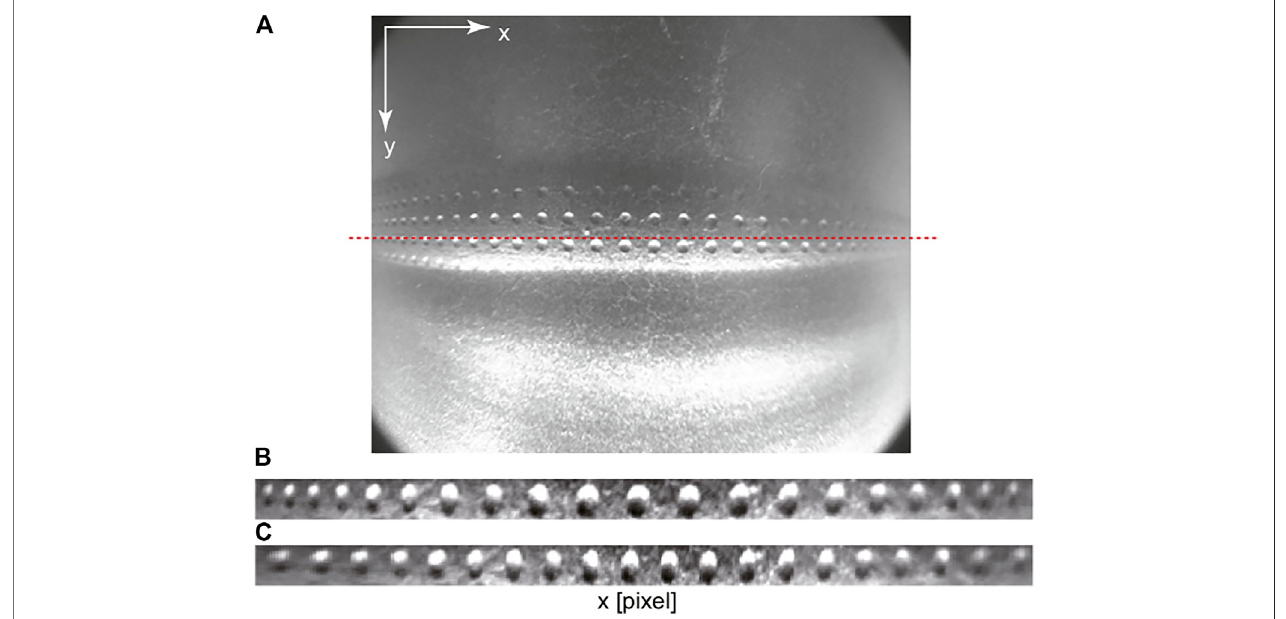
FIGURE 4 | Output image obtained from the tactile image sensor. (A) raw image. Red dashed line shows the center line in the y coordinate. (B) extracted image from the contact region without calibration, (C) calibrated image.